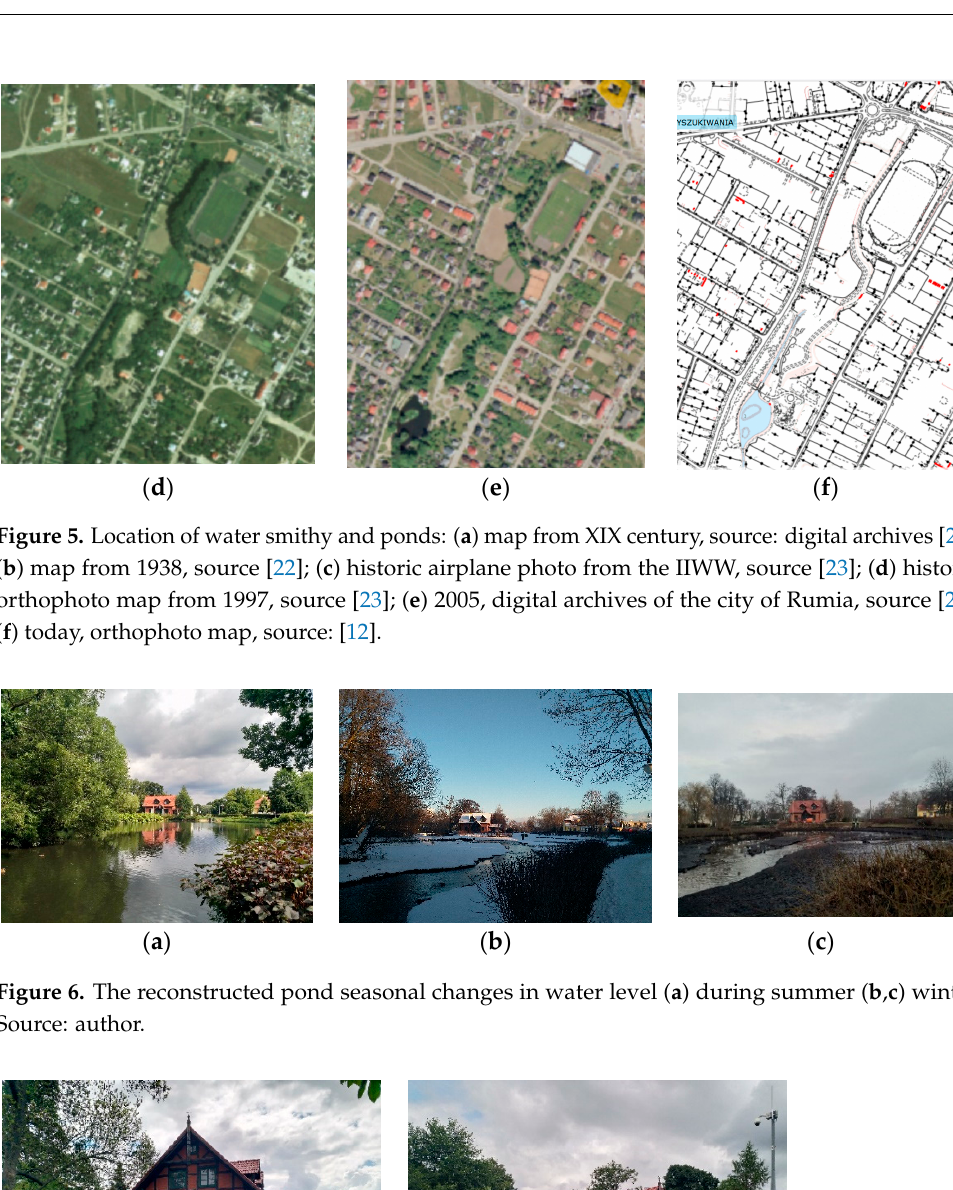
Figure 7. The water mill—a restaurant in the place of historic forge. ( a ) View from the riverside.